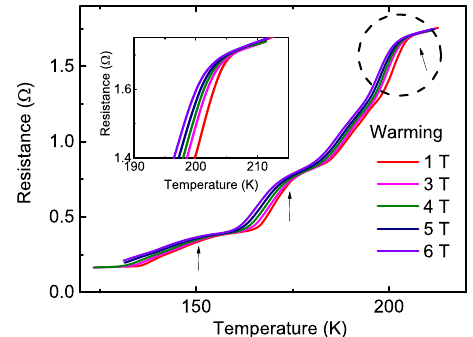
Fig. 2 The superconducting transitions with the applied magnetic fi elds. The resistance as a function of temperature measured at different magnetic fi elds for Sample A. The arrows are attributed to the phases with different hydrogen amount in the calcium superhydrides. The inset is the enlarged view of the resistance curves around the transition region of the 210K